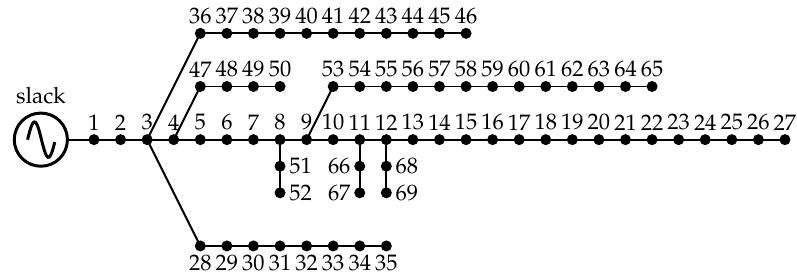
Figure 2. Schematic interconnection among nodes in the 69-nodes test